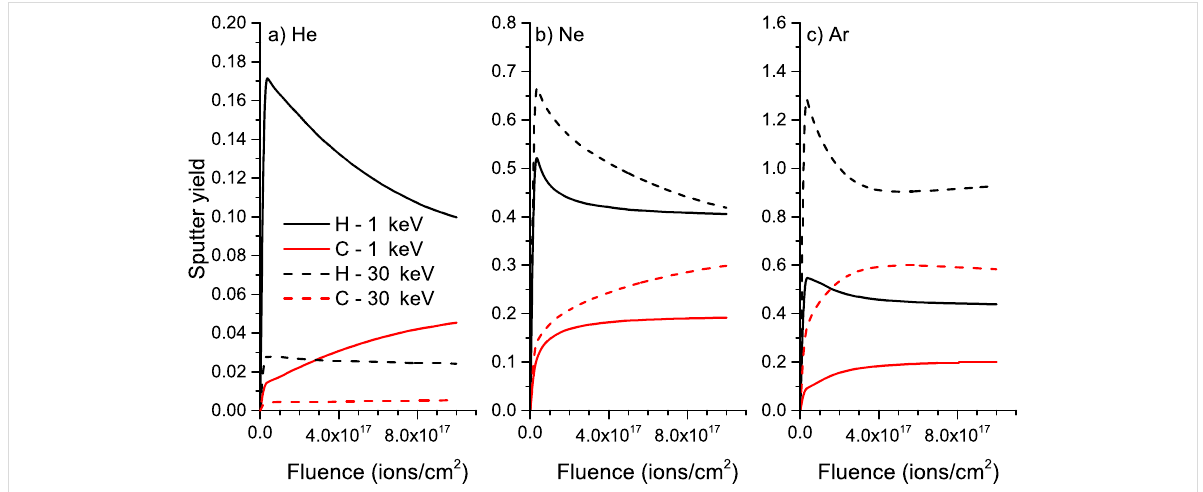
Figure 7: Evolution of sputter yields with fluence for a) helium, b) neon, and c) argon bombardment of PE at 1 keV and 30 keV.